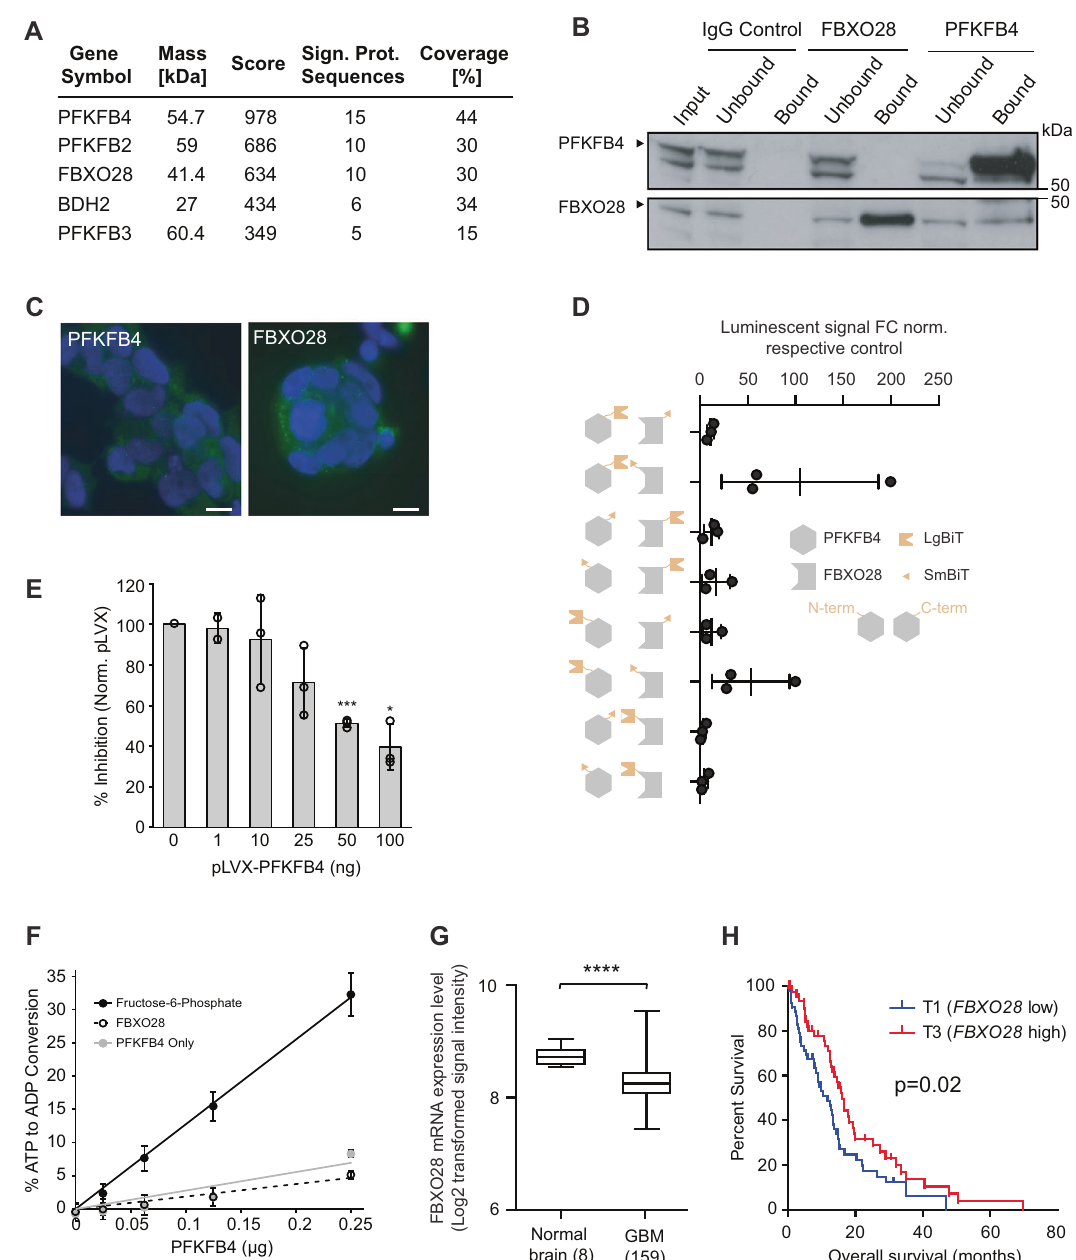
Fig. 4 FBXO28 is a novel interaction partner of PFKFB4. A Interaction partners of PFKFB4 in NCH421k GSCs as determined by mass spectrometry of immunoprecipitated PFKFB4 from NCH421k lysate. Proteins were only considered as identi fi ed if more than one unique peptide had an individual ion score exceeding the MASCOT identity threshold and if three or more unique peptide sequences were identi fi ed in all replicates and not in the controls. The experiment was performed in biological triplicate, with data from one biological replicate displayed here; further replicates shown in Table S2. B Immunoprecipitation of FBXO28 or PFKFB4 from NCH421k lysate, with IgG as a control. PFKFB4 and FBXO28 are shown on the immunoblot. C Immuno fl uorescent staining of PFKFB4 and FBXO28 in NCH421k GSCs. Scale bar = 10 µm. D Split NanoLuc ® Luciferase assay to determine the best combination of split fragments with the large (LgBiT) or small (SmBiT) BiT cloned onto the C- or N-terminal of either PFKFB4 or FBXO28. Data are normalized to the negative control, which is a combination of the halo tag labelled with the small BiT with either PFKFB4 or FBXO28 tagged with the large BiT. A luminescent signal that is at least 10 times the negative control was considered as positive. Data are represented as mean of biological triplicates ± SD. E Veri fi cation of the speci fi city of the interaction of SmBiT-tagged FBXO28 (N-term) to LgBiT-tagged PFKFB4 (C-term) using the Split NanoLuc ® Luciferase system. Increasing amounts of untagged PFKFB4-overexpressing pLVX plasmid were added to displace the tagged protein, with empty pLVX plasmid as a negative control. Data are depicted as percent inhibition compared with the pLVX only control. ( n = 3, mean ± SD, two sided t -test, * p value < 0.05 , ***p value< 0.001). F ADP-Glo ™ kinase assay measuring the percentage ATP to ADP conversion when increasing amounts of recombinant PFKFB4 was incubated with fructose-6-phophate, recombinant FBXO28 or no substrate. G FBXO28 mRNA in normal brain ( n = 8) compared with GBM patients ( n = 159). Data are represented as mean ± the minimum and maximum. The whiskers are drawn down to the 25th percentile and up to the 75th percentiles. H Survival of GBM patients with high (top tertile, n = 53; red) and low (bottom tertile, n = 53; blue) FBXO28